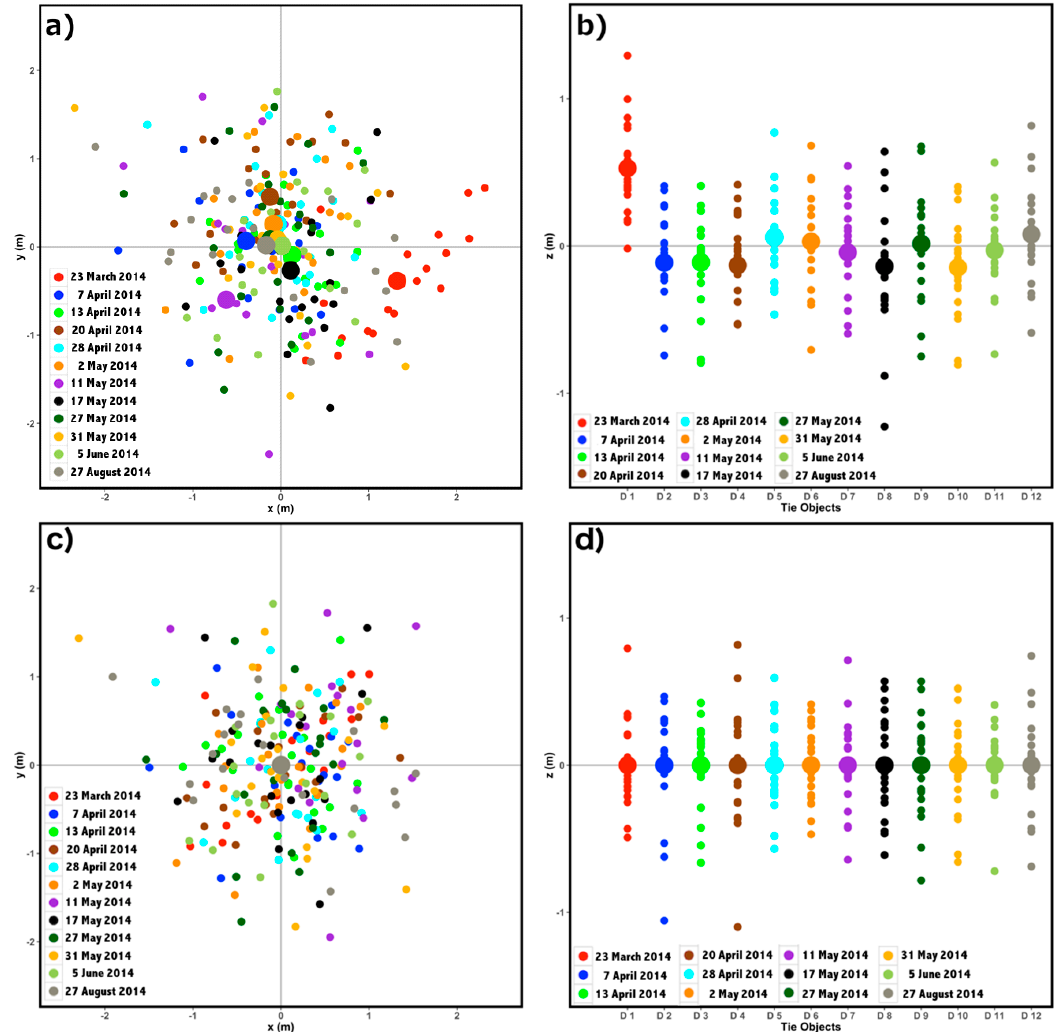
Figure 6. Vertices grouped by acquisition date (small dots) and corresponding centroids (large dots) before ( a , b ) and after ( c , d ) registering the point clouds in the horizontal ( a , c ) and vertical ( b , d ) dimensions. The coordinates of the vertices represent the distance and direction with respect to the corresponding tie object in planimetry and altimetry (refer to Figure 3c). The centroids correspond to the average distance values for each lidar acquisition and are indicators of their systematic bias. Due to the fact that the bias has been removed by our co-registration method, the centroids of the vertices in ( c , d ) are located over the origin of the corresponding reference (0,0). Table 1. Main statistics to summarize the graphs show in Figure 6a,b (original point cloud), c, and d (adjusted point cloud). The “vertex-based” columns refer to the distance between the vertices and the corresponding tie objects. The “centroid-based” columns refer to the distance between the centroids and the tie objects. All rows of the last two columns equal zero because the tie object location overlaps the centroid of the vertices. P and A stand for Planimetric and Altimetric dimensions.